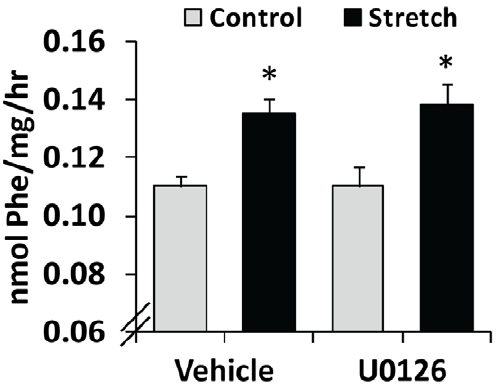
Figure 3. Mechanical stimulation induces an increase in protein synthesis via an ERK-independent mechanism. EDL muscles were held at Lo and pre-incubated with 50 m M U0126 or the vehicle (DMSO) for 30 min. The muscles were then subjected to 90 min of stretch or control conditions, and protein synthesis rates were measured during the final 30 min. All values are presented as the mean + SEM (n=4 2 7 per group). *Significantly different from the drug-matched control group, P # 0.05.